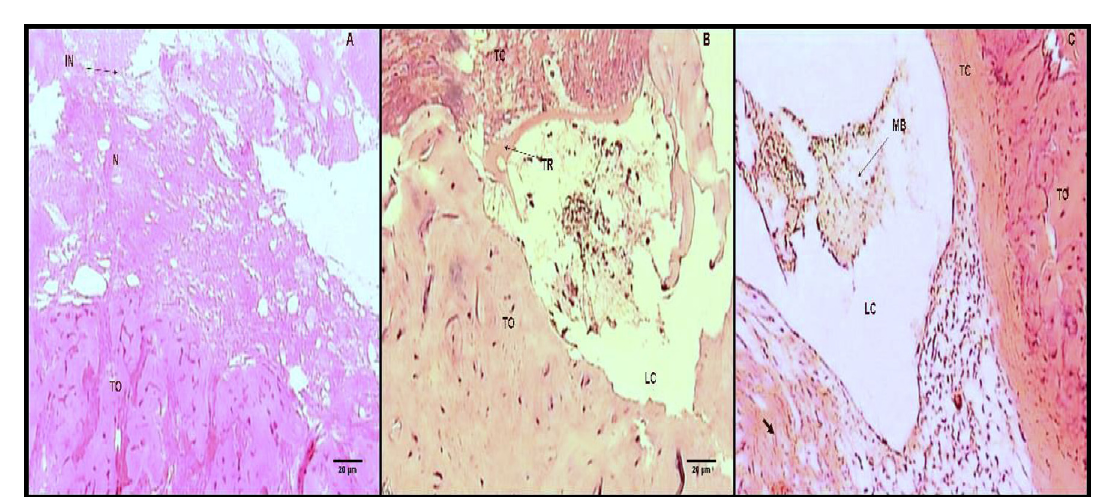
FIGURE 3 - Montage of photomicrographs of bone tissue sections from femurs of animals in Group 4, stained with hematoxylin-eosin, at 100x magnification. In A , group irradiated with laser and associated with BMP on the seventh day, with dose of 4 J/cm, showing neoformed bone (TR) and area of tissue necrosis (N). In B , group irradiated with laser and associated with BMP on the fourteenth day, showing bone neoformation (TR), cavity lesion (LC), presence of biological material (MB) and inflammatory cells (IN). In C , group irradiated with later and associated with BMP on the twenty-eighth day, showing presence of conjunctive tissue (TC), neoformed bone tissue (TO), biological material (MB) and cavity lesion. Scale bar = 20